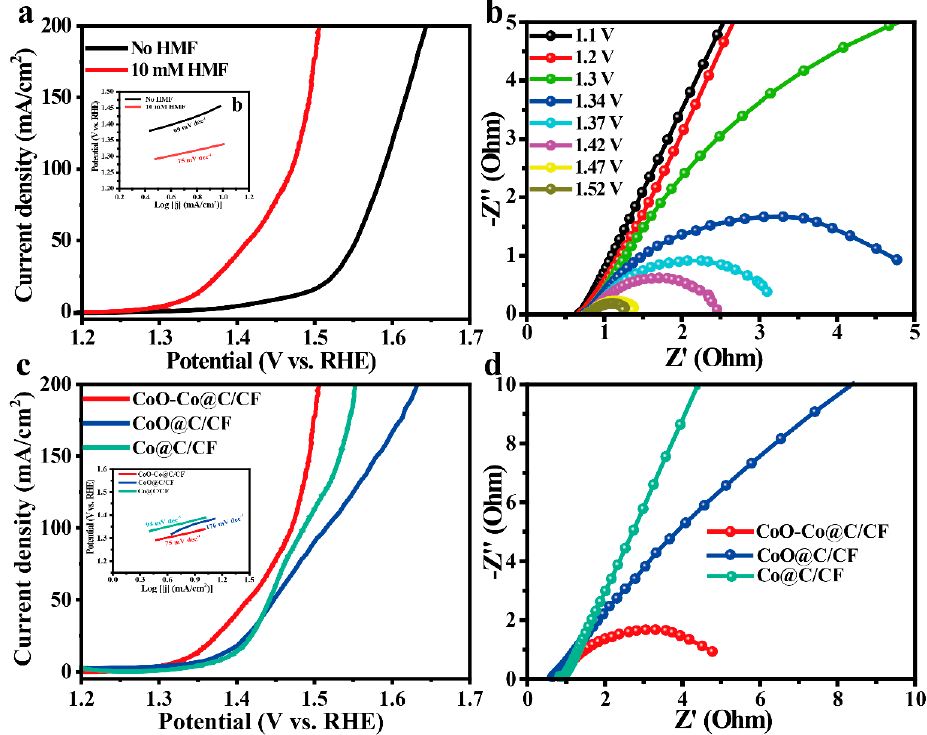
Figure 3. ( a ) iR-compensated polarization curves of HMFEOR over CoO–Co@C/CF in 1.0 M KOH with/without 10 mM HMF at the scan rate of 5 mV · s − 1 (inset: corresponding Tafel plots). ( b ) Potential- dependent Nyquist plots of CoO–Co@C/CF in 1.0 M KOH with 10 mM HMF. ( c ) Polarization